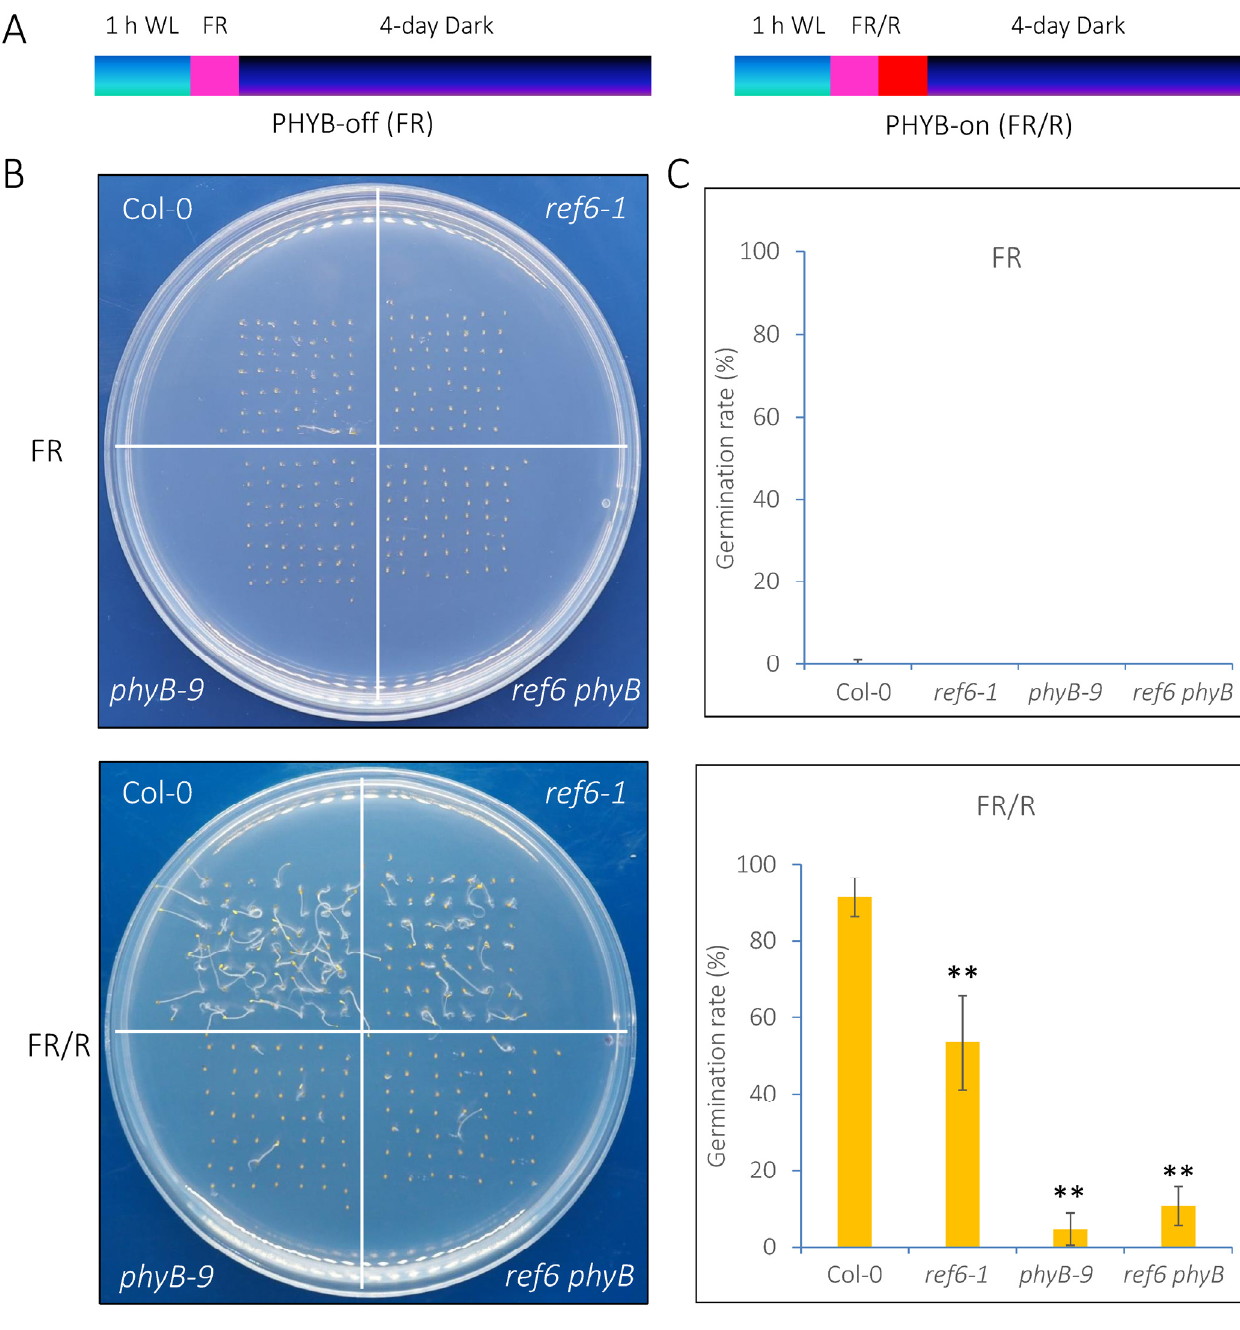
Figure 2. Genetic analysis of REF6 and phyB in the phyB-dependent seed germination process. ( A ) Diagram displaying the phyB-inactivated (phyB-off, FR) and phyB-activated (phyB-on, FR/R) assays. ( B ) Germination patterns of Col-0, ref6-1 , phyB-9 and ref6 phyB seeds under FR (phyB-off) and FR/R (phyB-on) conditions. ( C ) Statistical analysis of the germination rates of Col-0, ref6-1 , phyB-9 and ref6 phyB seeds under FR and FR/R conditions. Asterisks indicate significant differences (** p < 0.01, Student’s t -test). The experiments were performed in triplicate, and 50 seeds were scored for each sample.